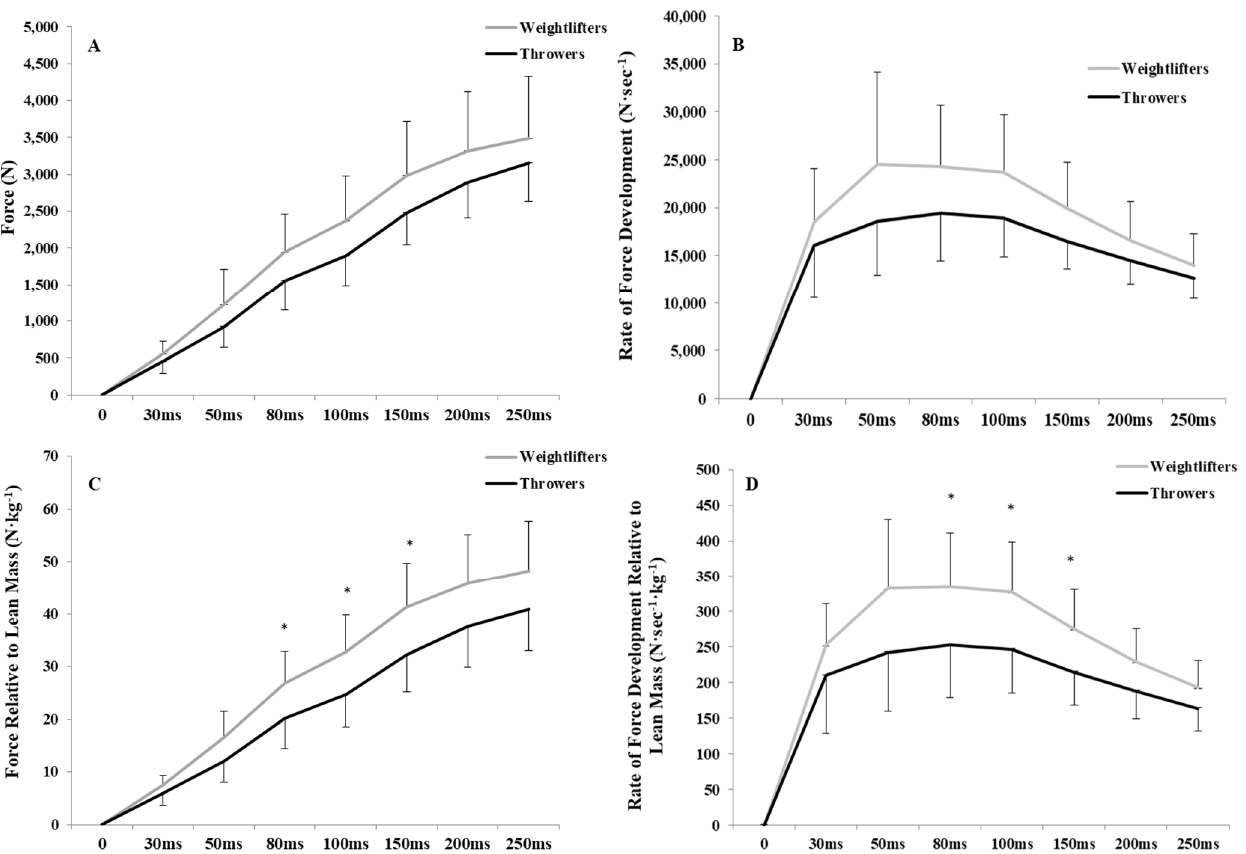
Figure 1. ( A ) Force production in absolute values during the isometric leg press measurement ( ± SD). No significant differences were observed between groups. ( B ) Rate of force development in absolute values ( ± SD). No significant difference was observed between weightlifters and throwers. ( C ) Force production relative to total lean mass ( ± SD). Significant difference at 80, 100 and 150 ms between weightlifters and throwers. ( D ) Rate of force development relative to total lean mass ( ± SD). Significant difference at 80, 100 and 150 ms between weightlifters and throwers. * denotes a significant difference between weightlifters and